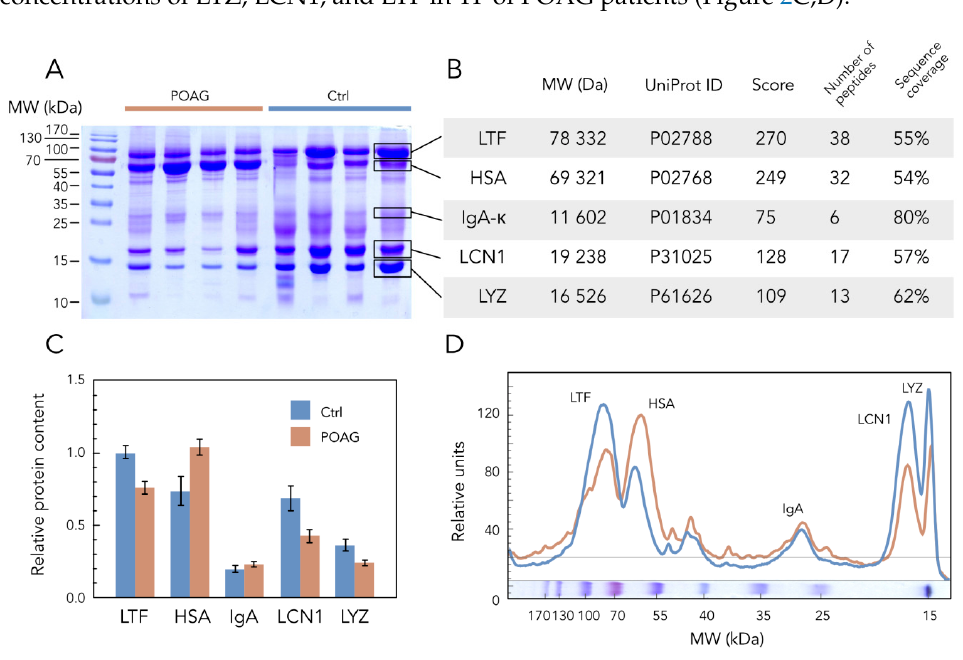
Figure 2. POAG-related alterations in core TF proteins. ( A ) Representative SDS-PAGE image of TF samples obtained from POAG and control (Ctrl) patients (each track contains 20 µL of the sample). Protein standards in kDa are noted in the left column. ( B ) Identification of the protein bands indicated in panel A, using tryptic peptide mass fingerprinting by MALDI-TOF mass spectrometry. Molecular weights (Mr) and accession numbers (UniProt ID) of the proteins and identification scores (Score), as well as the number of detected peptides and sequence coverage data in %, are provided. ( C , D ) The average weight fractions of the core tear proteins estimated from the SDS–PAGE of TF samples from POAG and control (Ctrl) groups by densitometric scanning of the bands. Data were handled using GelAnalyzer software version 19.1. Error bars in panel C represent standard deviation ( p < 0.05 with respect to POAG versus control for all proteins except IgA).